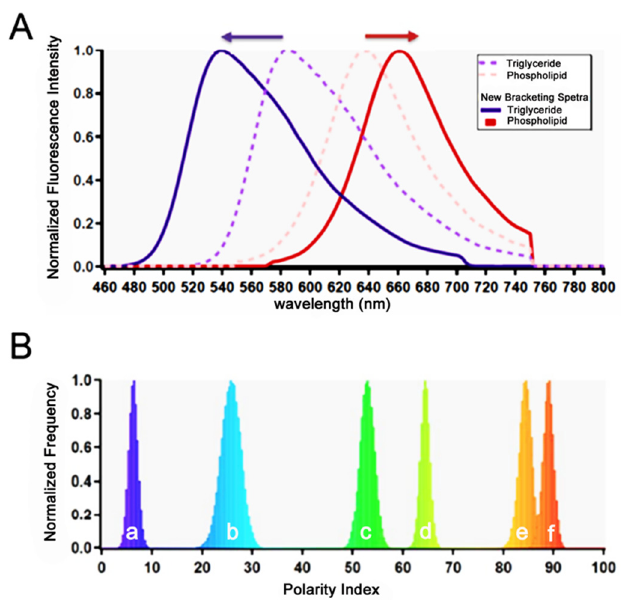
Figure 1. Polarity index measurements by Nile Red spectral shifts. ( A ) The blue edge bracketing spectra (solid blue line, 540 nm peak) is derived from the Invitrogen library, using the spectra of Nile Red emission as dissolved in triglyceride (553 nm peak, broken purple line), and shifting it to the blue by 13 nm. In a similar fashion, the red edge bracketing spectra (solid red line) is also derived from the Invitrogen library (Nile Red emission as dissolved in phospholipid, 637 nm peak, broken pink line) by shifting it to the red by 23 nm. ( B ) Emission histogram data for monomolecular solvents expressed as Polarity Index: (a) hexane, (b) Toluene, (c) chloroform (d) acetone (e) DMSO (f) Methanol. In this fashion, the x-axis covers enough emission breadth to capture emission data from Nile Red in opposite extremes of monomolecular polarity.